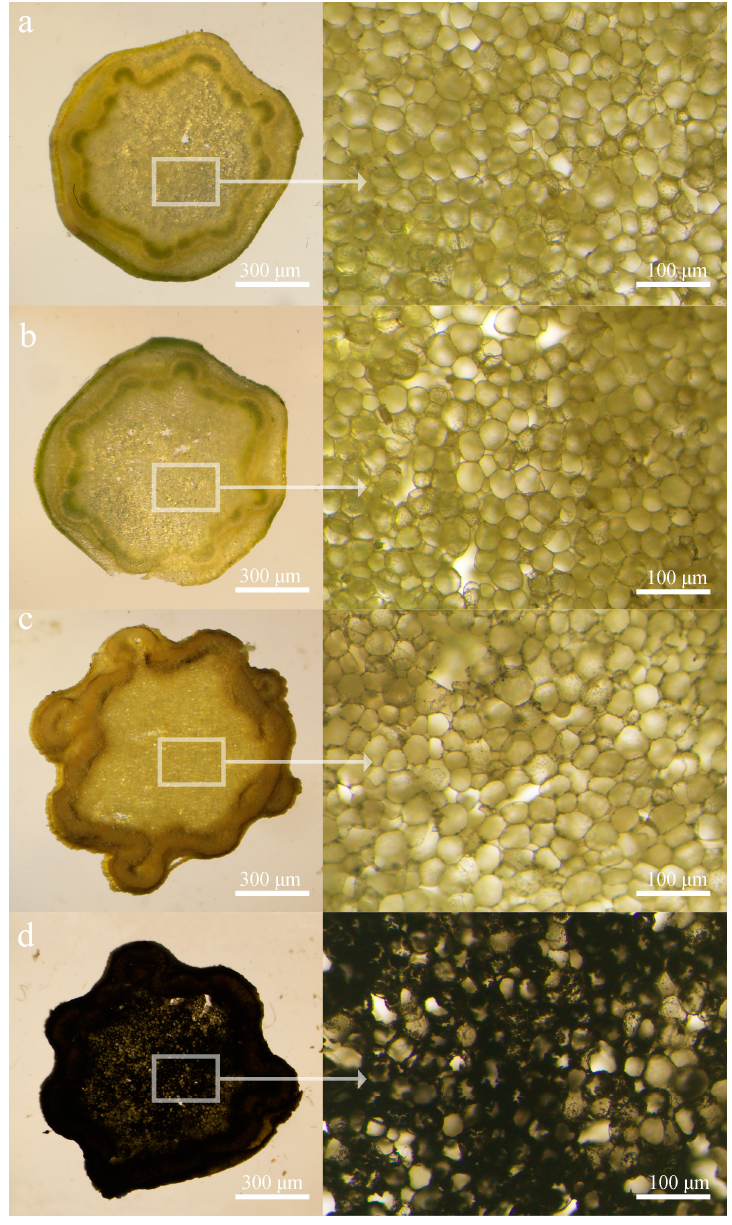
Figure 4. Microstructures of stem ends. ( a ) Polyphenol treatment for 0 day; ( b ) control for 0 day; ( c ) polyphenol treatment for 6 days; and ( d ) control for 6 days.